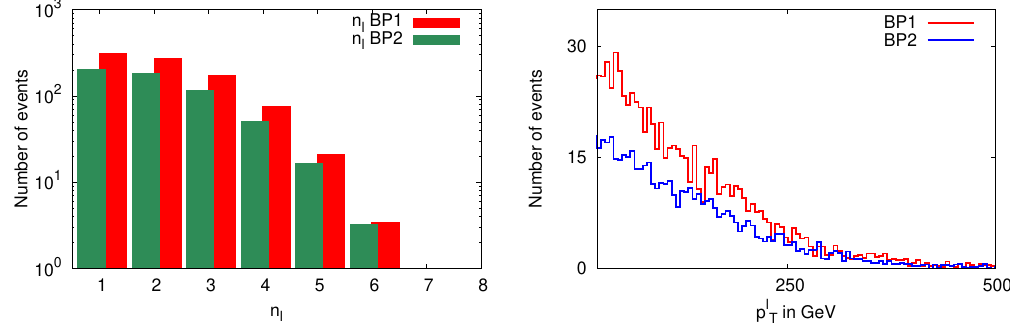
Figure 1 . n ‘ distribution (left panel) and p ‘ integrated luminosity of 100 fb (cid:0) 1 at the LHC with center of mass energy of 14 TeV.